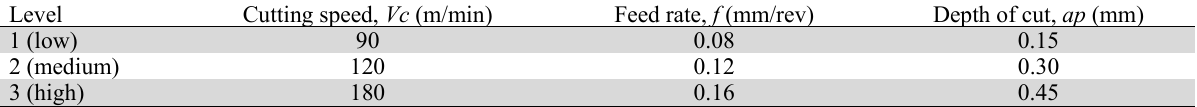
Attribution of the levels to the factors.